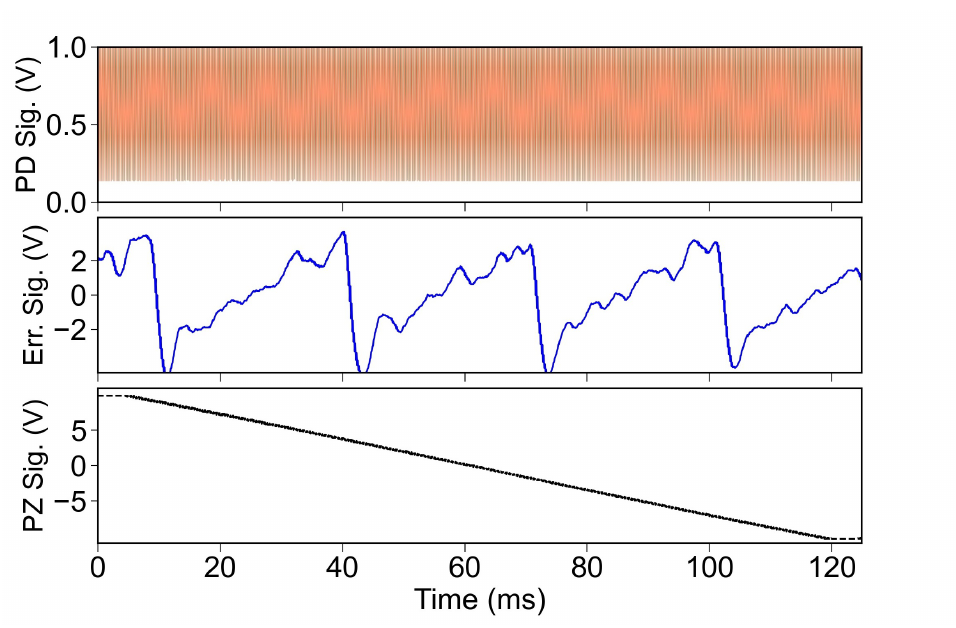
Figure 4. PD and error signals in CW+pulsed mode—scanning.